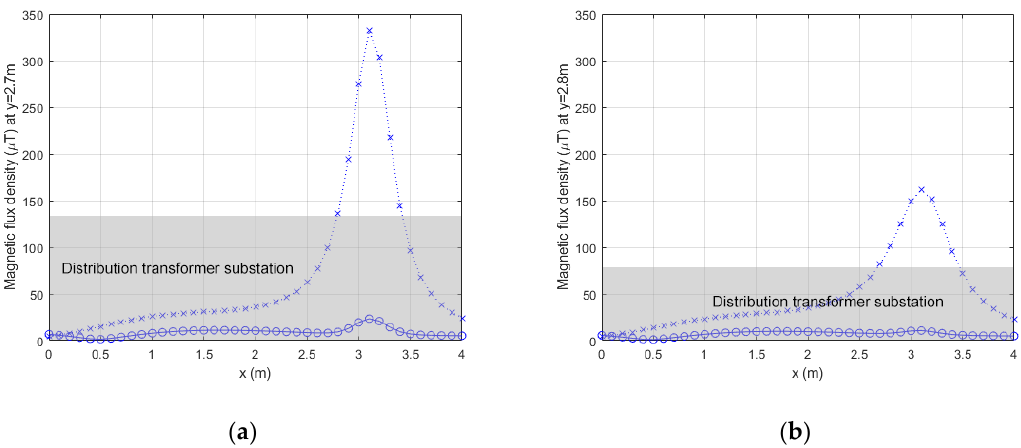
Figure 15. MFD on the sidewalk at a height of 100 cm (z = 1 m) at y = 2.7m ( a ) and at y = 2.8m ( b ) for the original situation (crosses) and for the proposed alternative (circles).